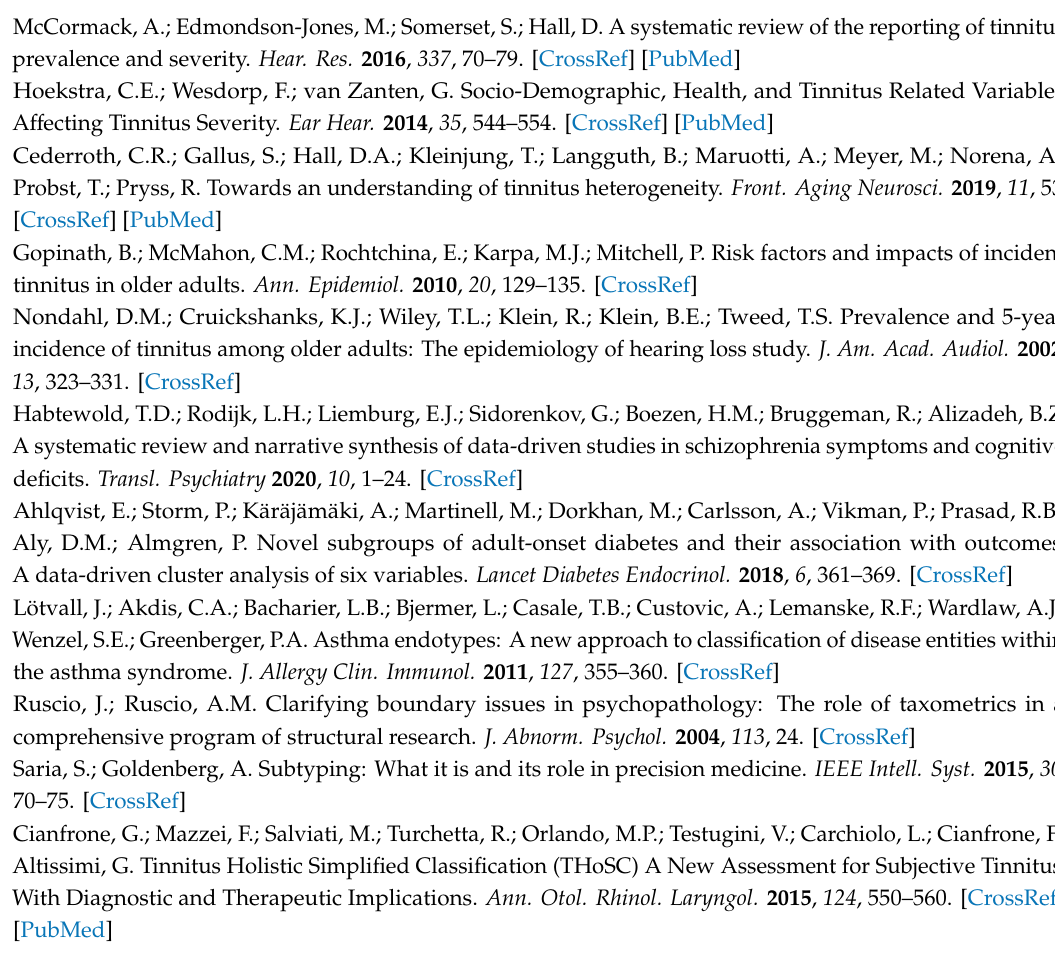
Table S1: Non tinnitus-specific variables, Table S2: Tinnitus-specific variables, Table S3: Data extraction